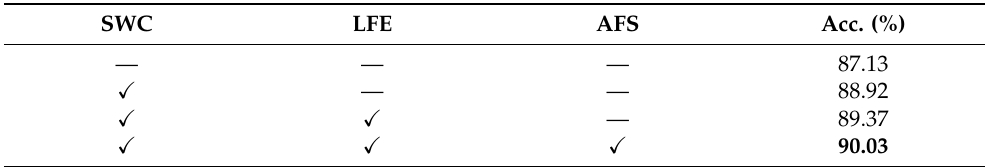
Table 1. Evaluation of each module in our model on the RAF-DB dataset. ’—’ indicates that the module is not used; ’ (cid:88) ’ indicates that the module is used.